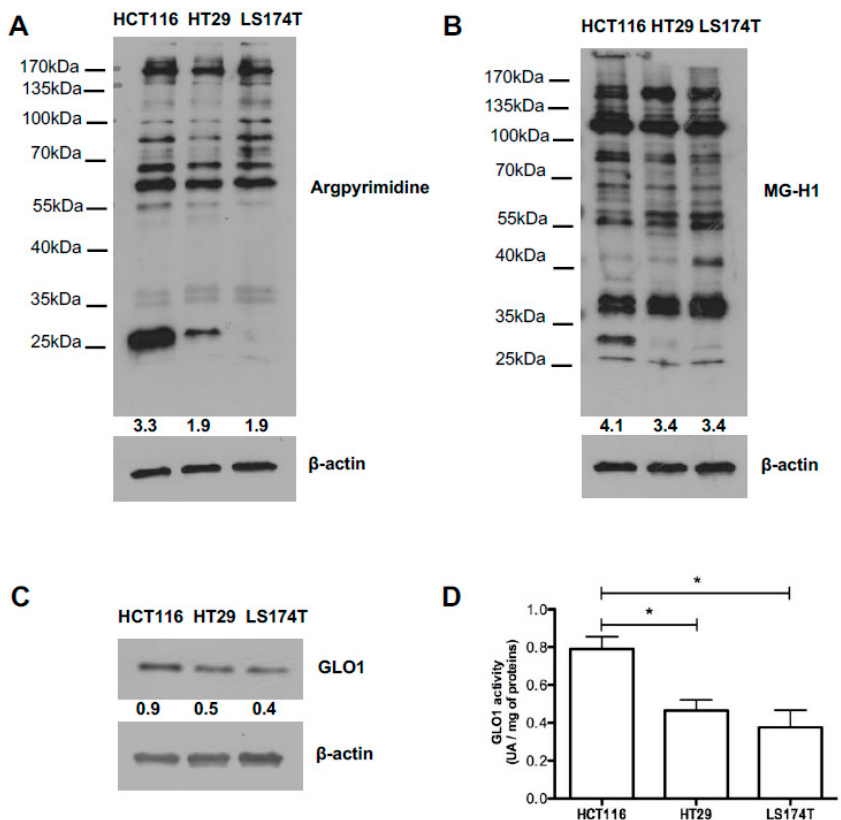
Figure 4. In vitro characterization of colorectal cancer cell lines. ( A ) Argpyrimidine and ( B ) MG-H1 accumulation has been evaluated in HCT116, HT29 and LS174T human colorectal cancer cell lines using Western blot analysis; ( C ) GLO1 basal expression and ( D ) activity in HCT116, HT29 and LS174T cells. All immunoblots were quantified by densitometric analysis and normalized for β -actin. Statistical analysis has been performed using Newman–Keuls multiple comparison test, * p < 0.05. All data are representative of three independent experiments ( n = 3) as the mean values ± SEM.